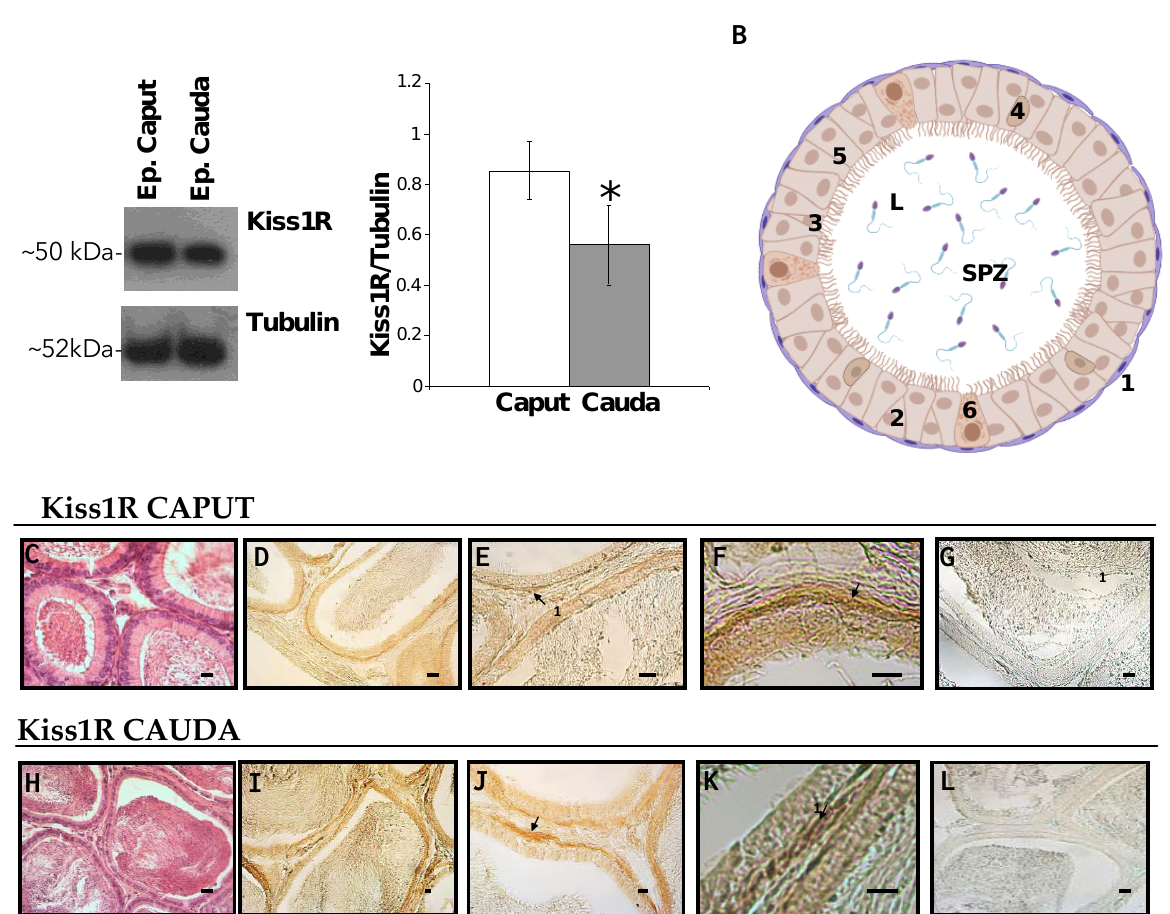
Figure 6. Expression and localization of Kiss1R in rat epididymis. ( A) Western blot for Kiss1R in spermatozoa free epididymis (Ep.) caput and cauda. ( B ) Schematic representation of cell types in epi- didymal epithelium, with Kiss1R immunoreactive cells in violet. 1: Myoid cells; 2: basal cells; 3: apical cells, 4: Halo cell, 5: principal cells, 6: clear cells, L: lumen, SPZ: spermatozoa. ( C – G ) Histological sections of caput epididymis; ( H – L ) Histological sections of causa epididymis. ( C , H ) Haematoxylin- eosin staining. ( D – G ), ( I – L ): immunohistochemistry analysis for Kiss1R. ( G , L ): controls of immunore- actions. Arrows indicate Kiss1R immunoreactive cells. Asterisk indicates statistically significant differences ( p <